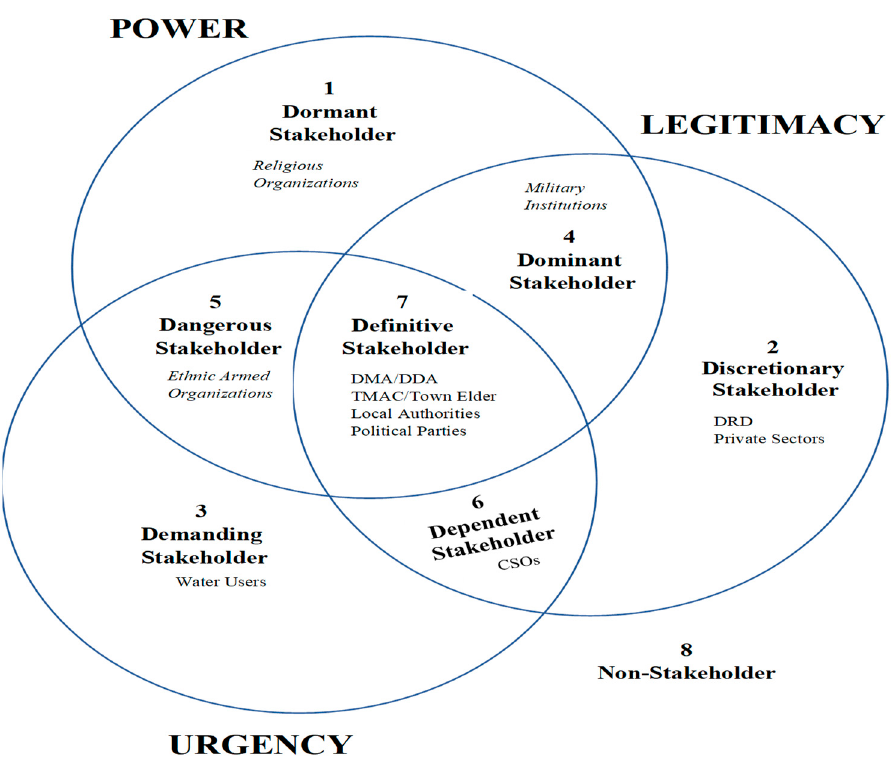
Figure 4. Power dynamics of water supply stakeholders in Rakhine State. TMAC = Town Municipal Affairs Committee, CSOs = Civil Society Organizations, DMA/DDA = Department of Municipal/ Development Affairs, DRD = Department of Rural Development.